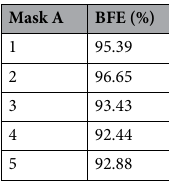
Table 3. BFE of 5 sample mask of model Mask A.